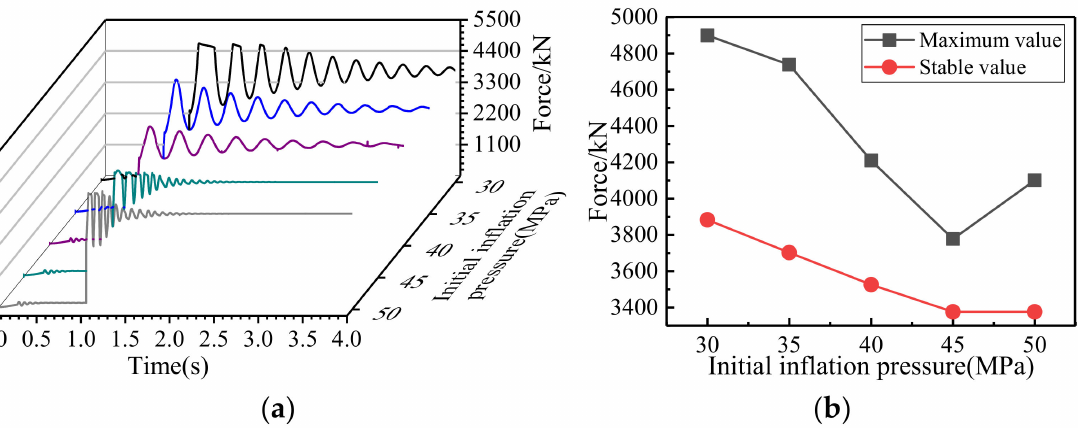
Figure 9. ( a ) The force comparison of hinge point between top beam and the balance jack. ( b ) Peak force and stable force of hinge point.